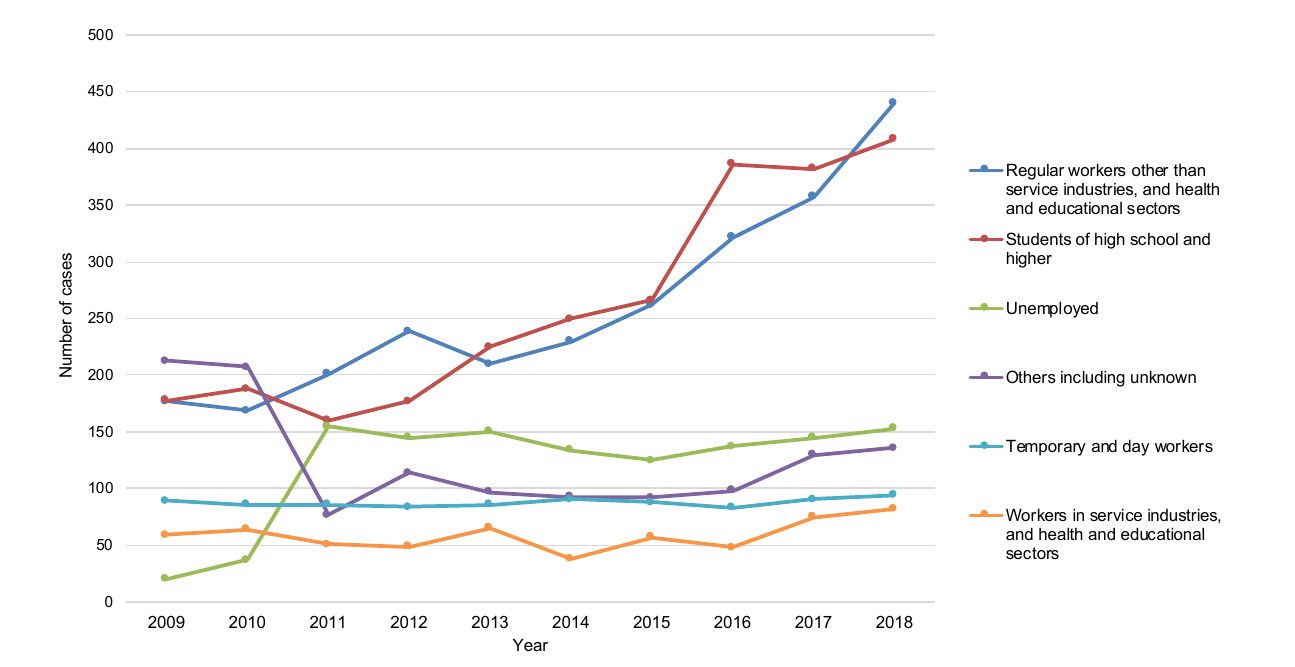
Figure 2. The number of overseas-born patients with pulmonary tuberculosis by occupation or social status in 2009–2018.